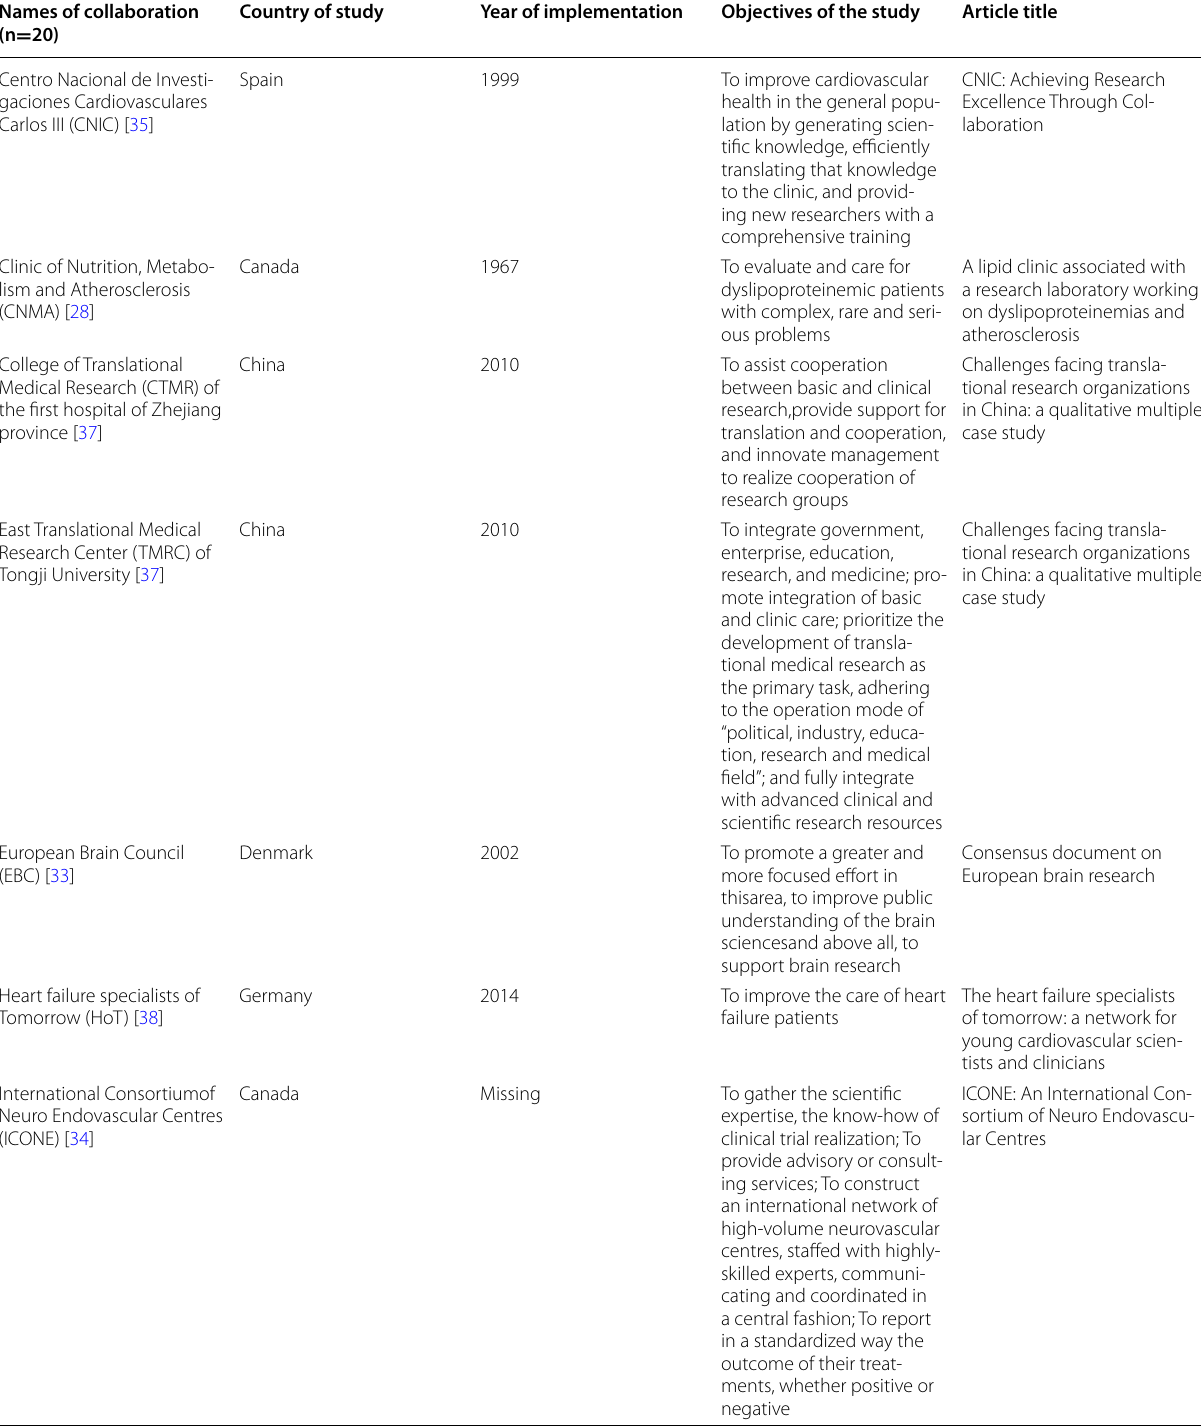
Table 4 Description of collaboration models Names of collaboration